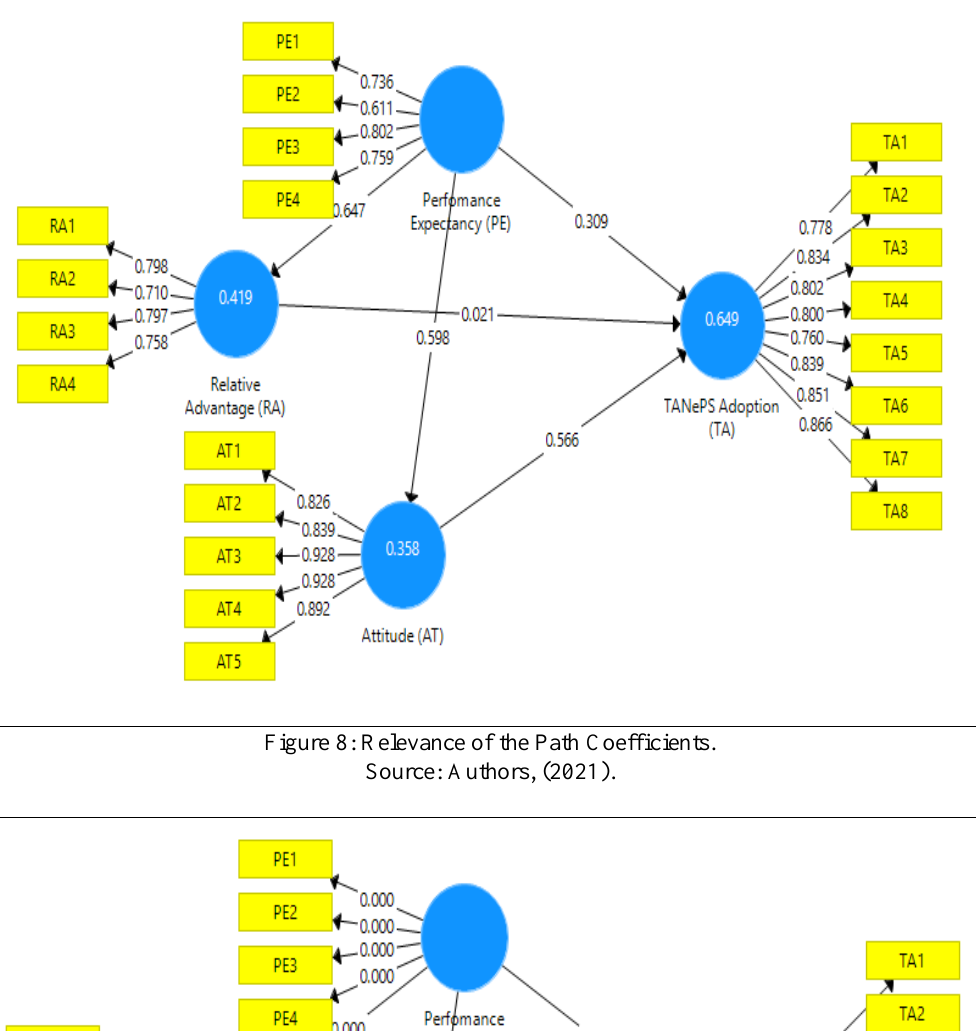
Figure 8: Relevance of the Path Coefficients.